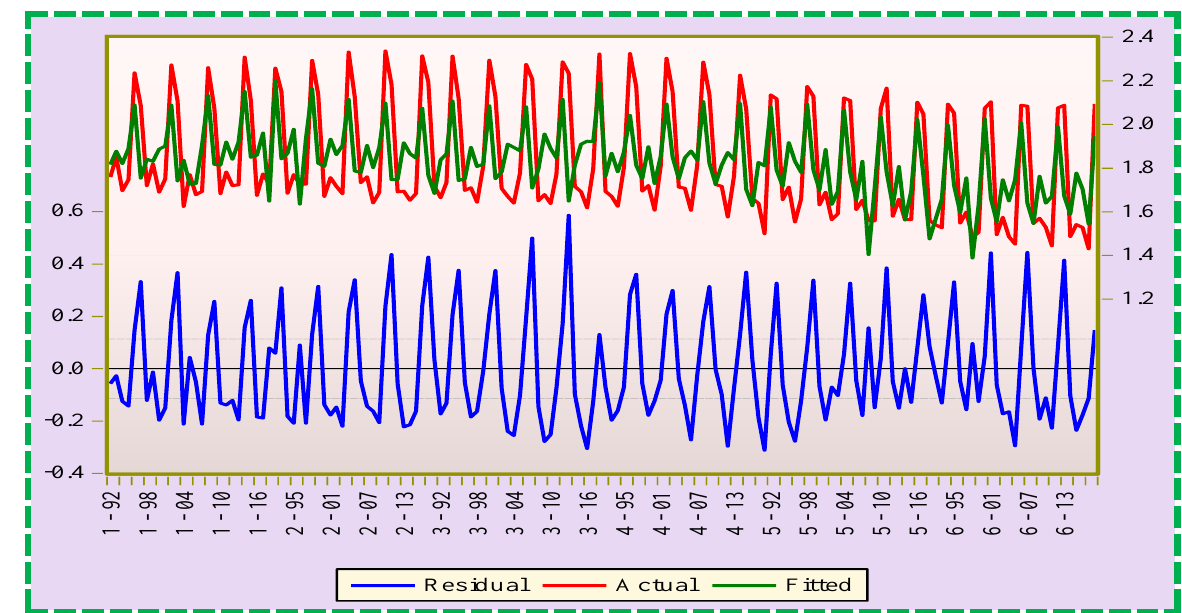
Figure 5. Actual, Fitted, and Residual plot of ecological footprint function.